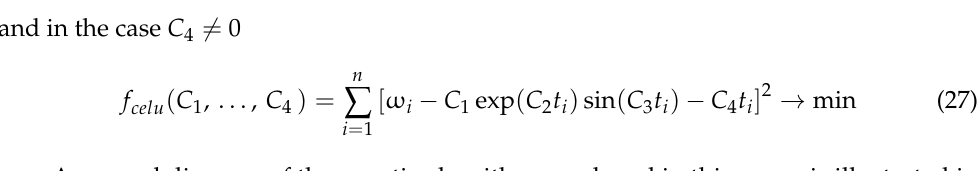
Table 1. Genetic algorithm